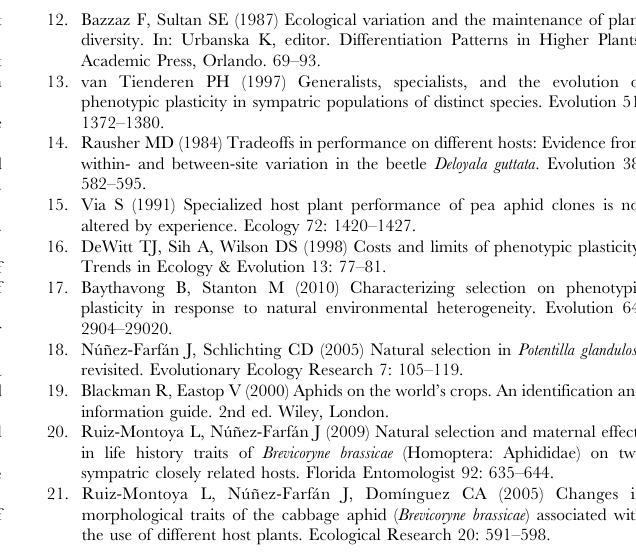
Table S1 Original data set of morphologic and life history measure of Brevicoryne brassicae genotypes reared on Brassica oleracea and Brassica campestris